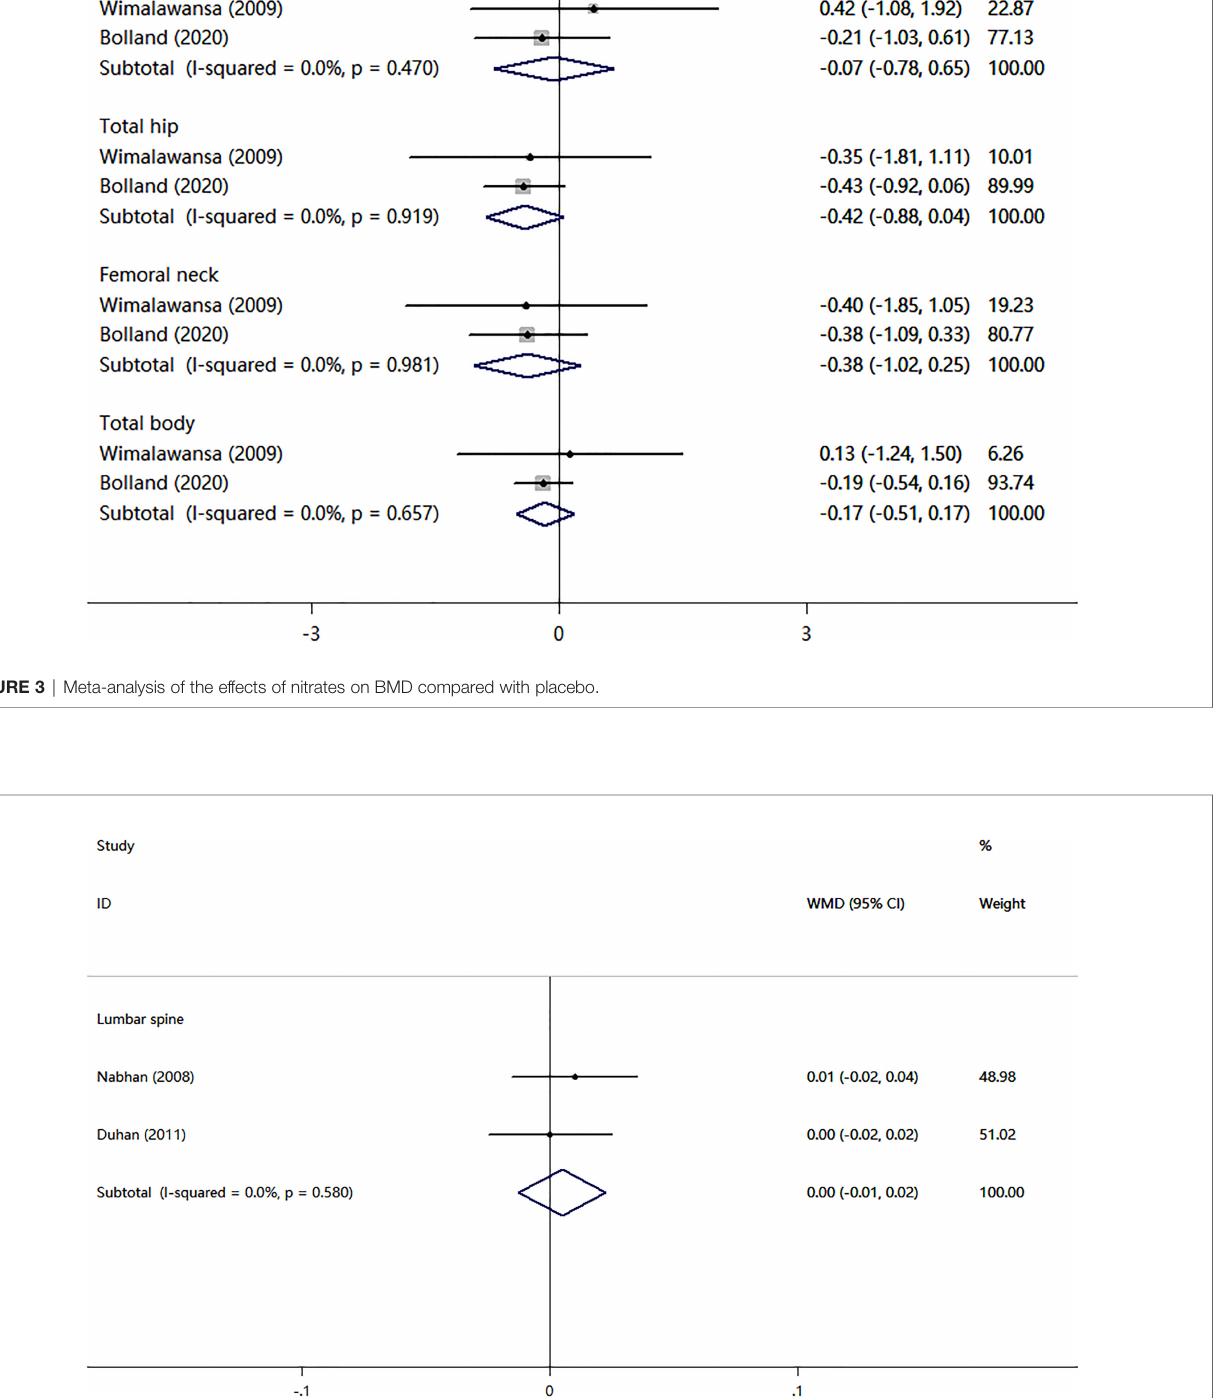
FIGURE 4 | Meta-analysis of the effects of nitrates on lumbar spine BMD compared with alendronate.